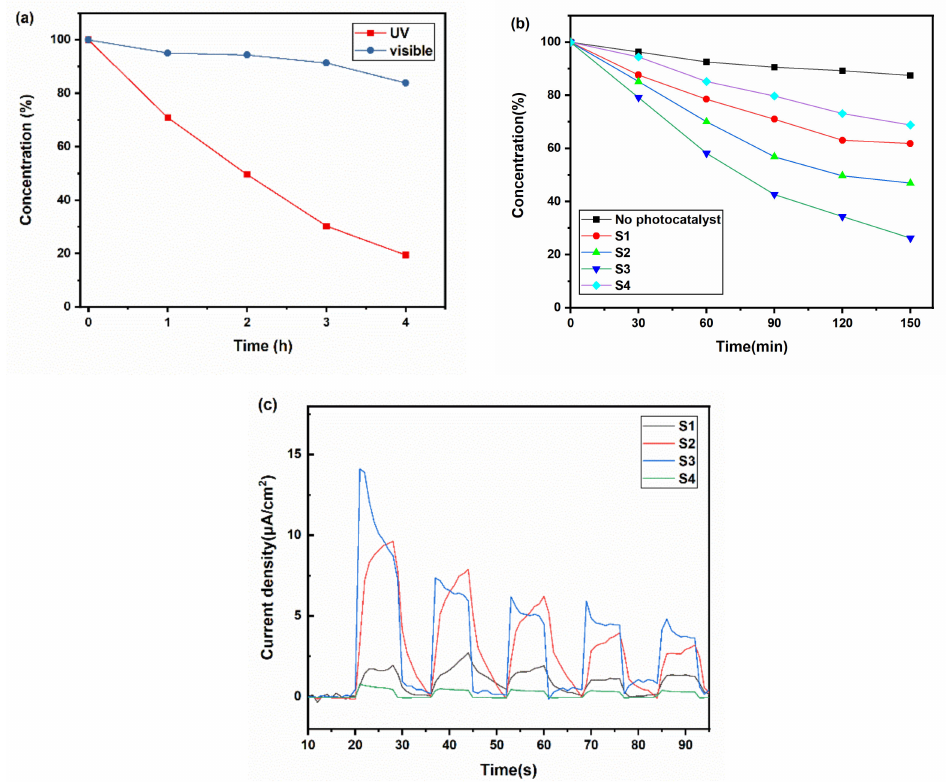
Figure 5. ( a ) The dye degradation dynamic curve of Sample S3 under visible light and ultraviolet; ( b ) the dye degradation dynamic curve of Sample S1, S2, S3, and S4 under UV light; ( c ) the photoelectric current of Sample S1, S2, S3, and S4 under visible light.